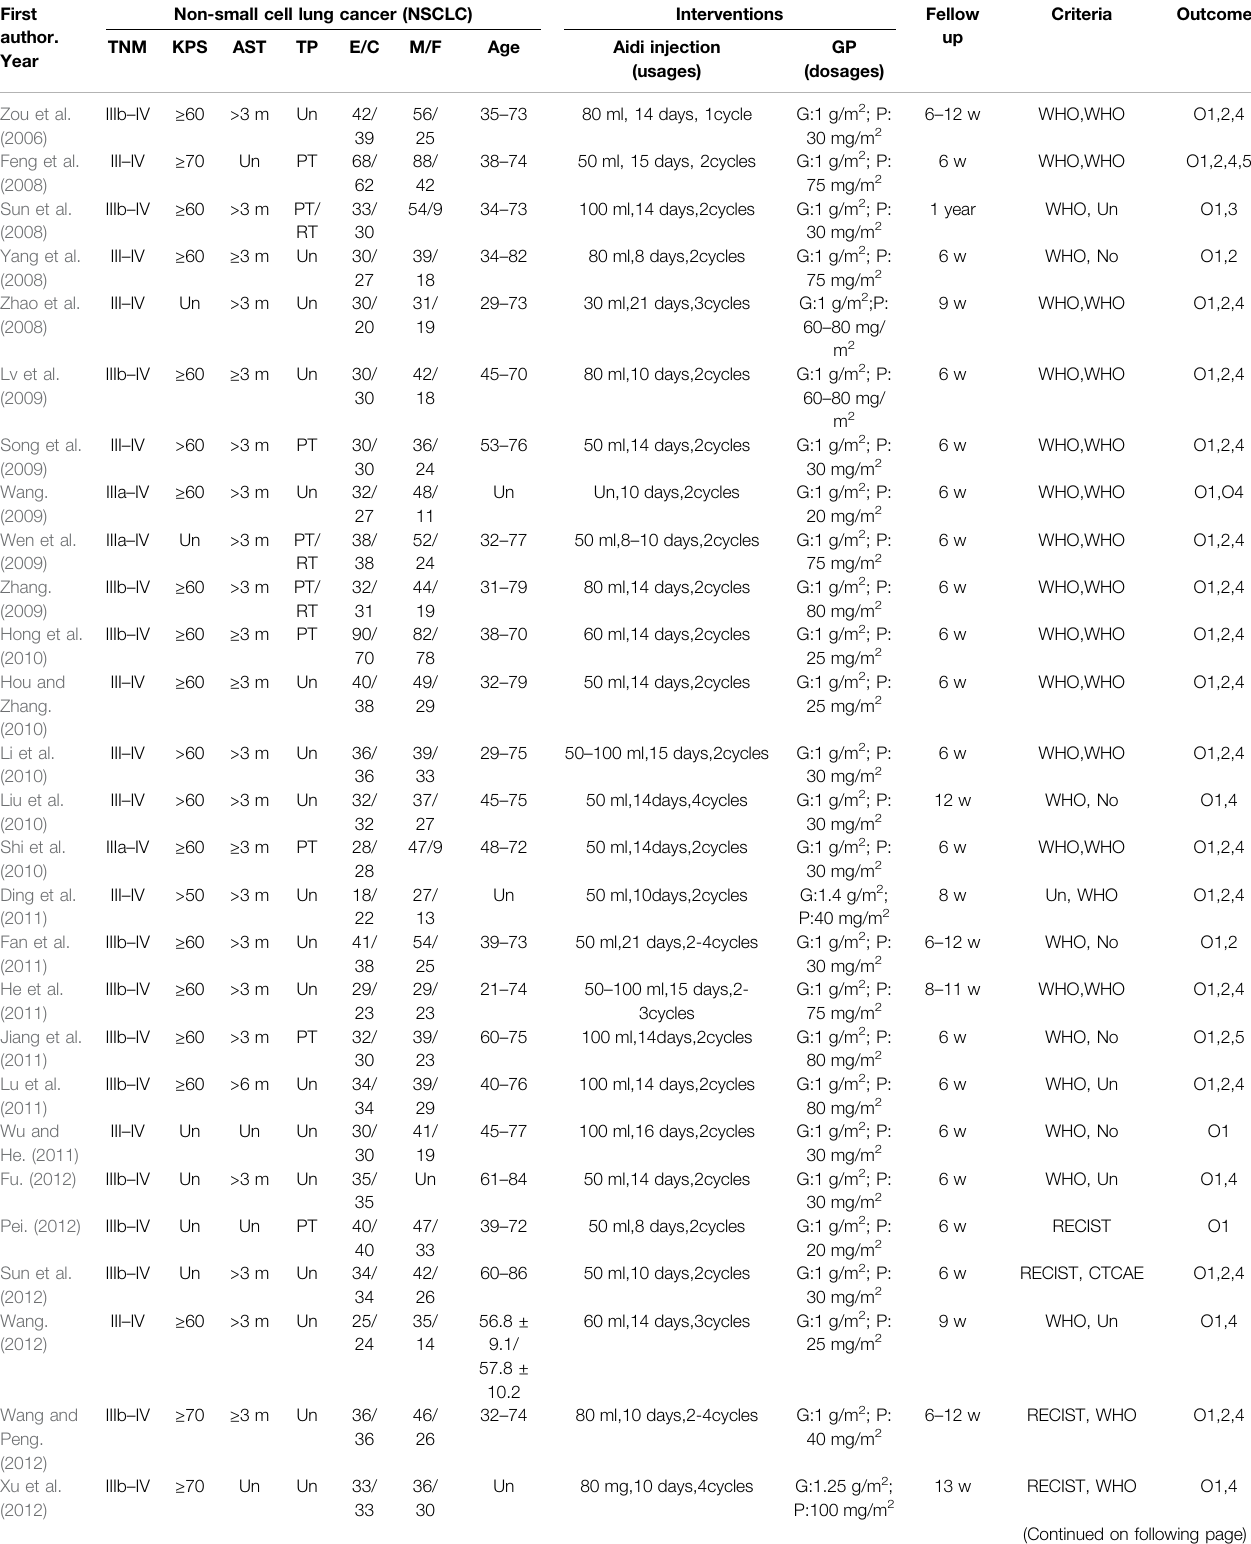
TABLE 1 | Basic features of the included